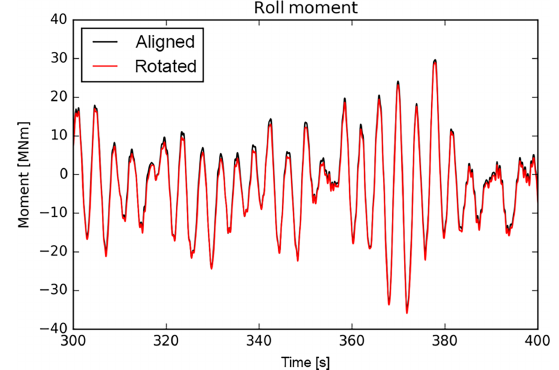
Figure 27. Roll moment for wind–wave direction 0 and 45 ◦